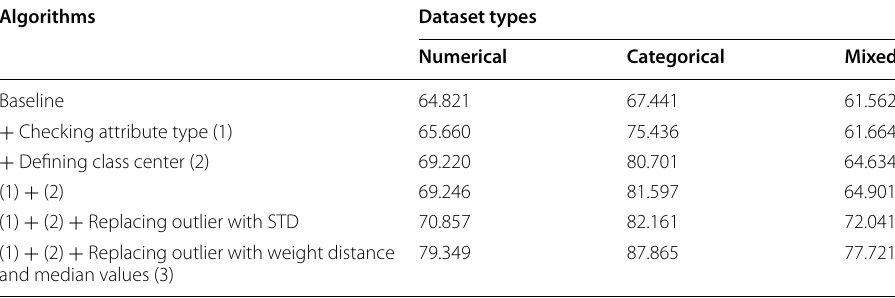
Table 15 Average classification accuracies for comparison algorithms of the proposed method